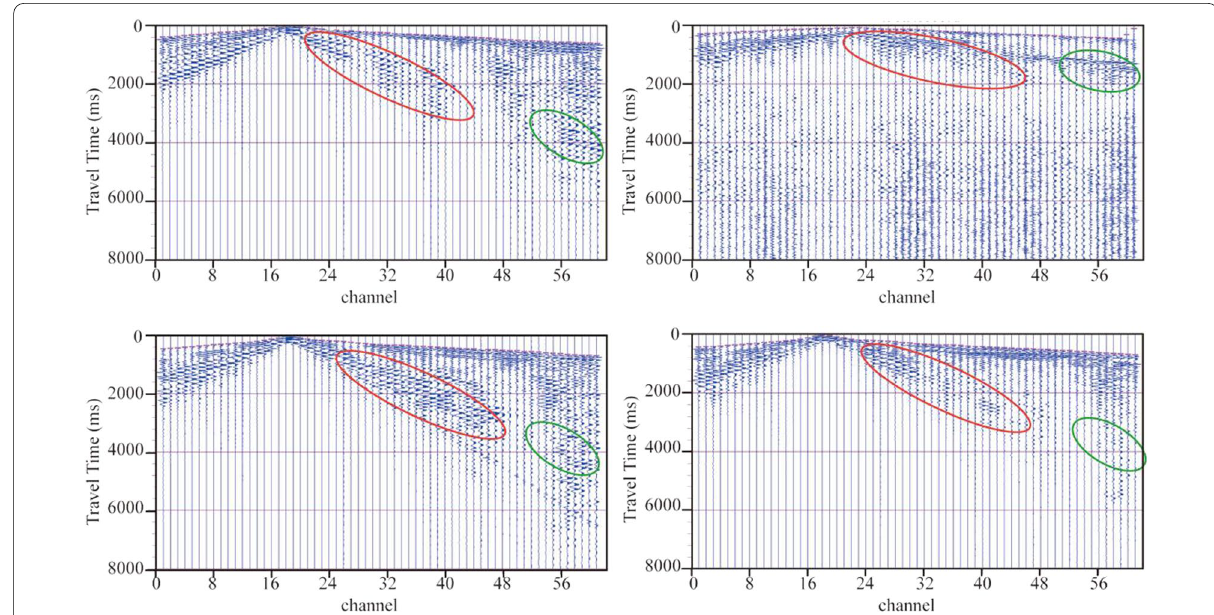
Fig. 2 Original single-shot data (red ellipse is near offset and green ellipse is far offset)